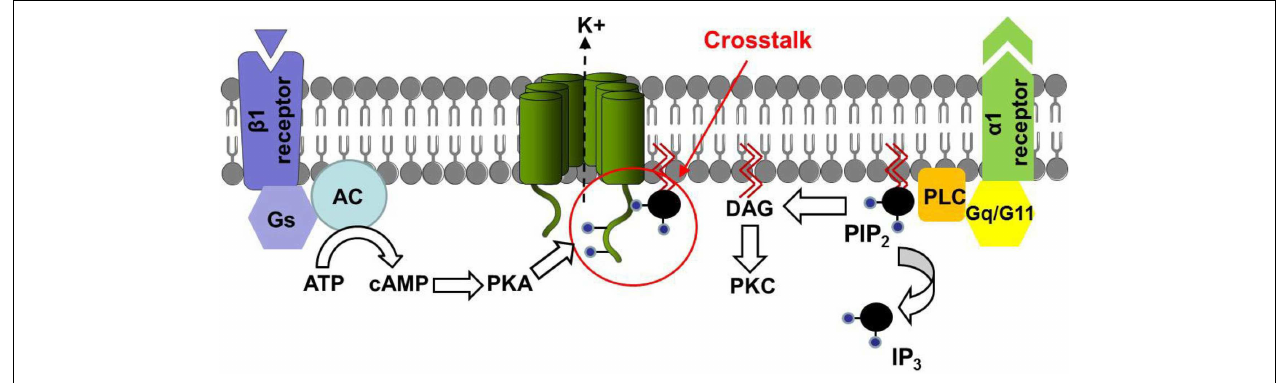
modulation of the channel. Lopes et al. showed that this model is FIGURE 3 | Model of the regulation of channel-PIP2 interactions by PKA. β 1-adrenergic receptor regulates channel-PIP transposable to KCNQ1 andTREK1 channels. Adapted from Lopes et al. 2 interaction through PKA phosphorylation, and simultaneously regulates Gq/G11-protein coupled